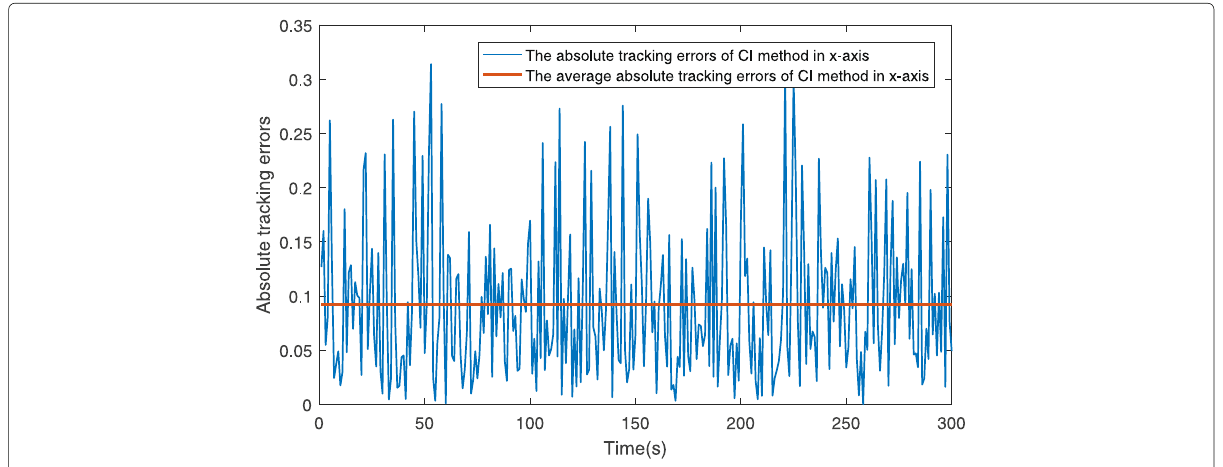
Fig. 6 The absolute tracking errors of CI method in x -axis with a i =